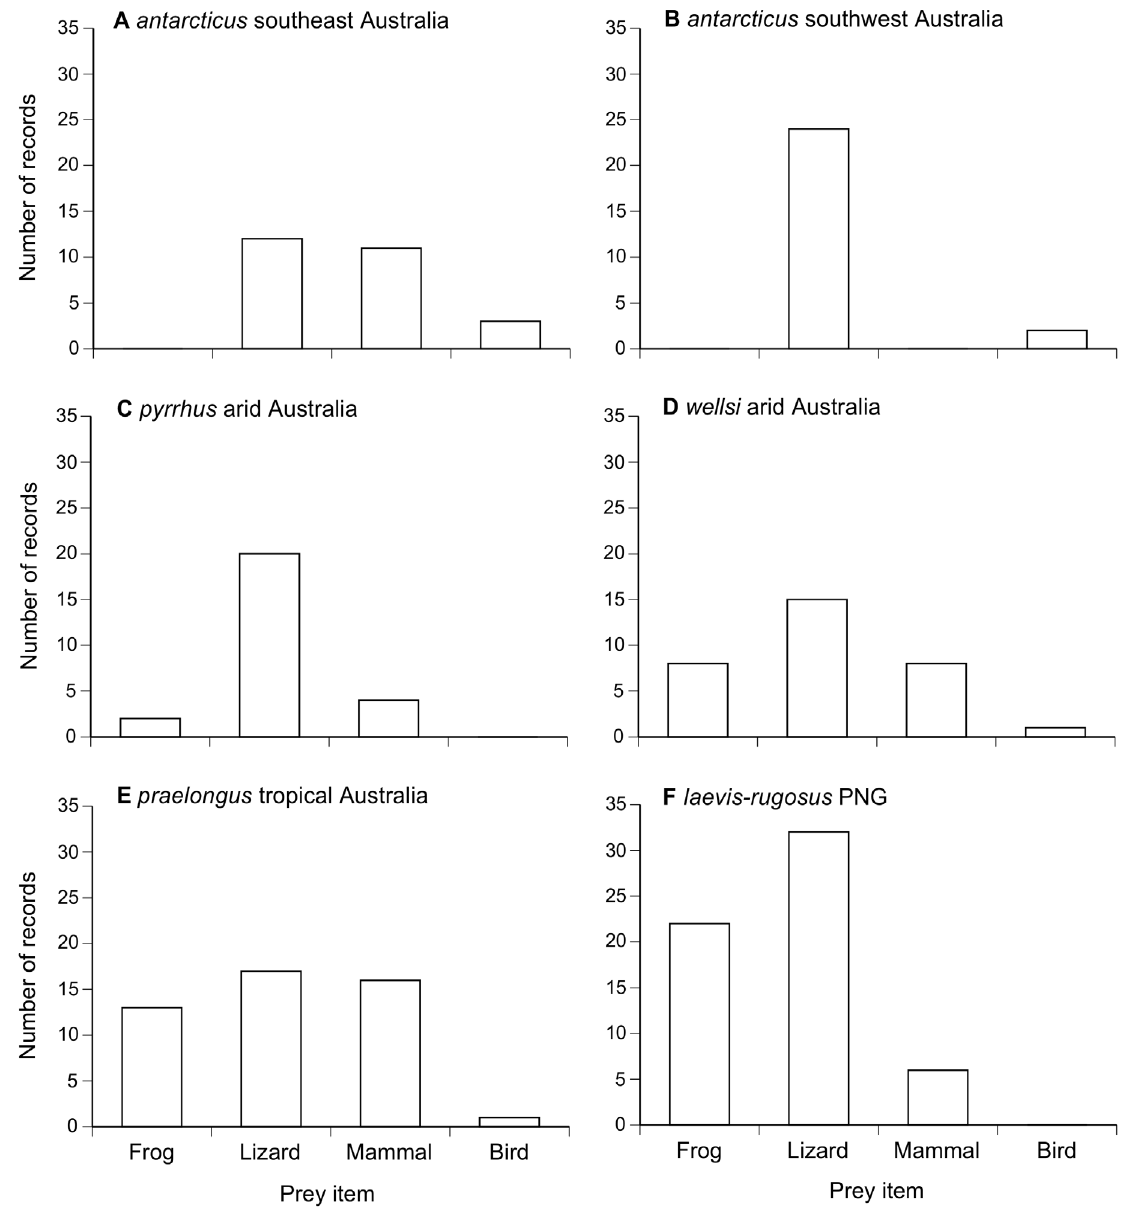
Figure 5. Composition of the diet in death adder species (genus Acanthophis ). Numbers of prey are based on dissection of museum specimens.